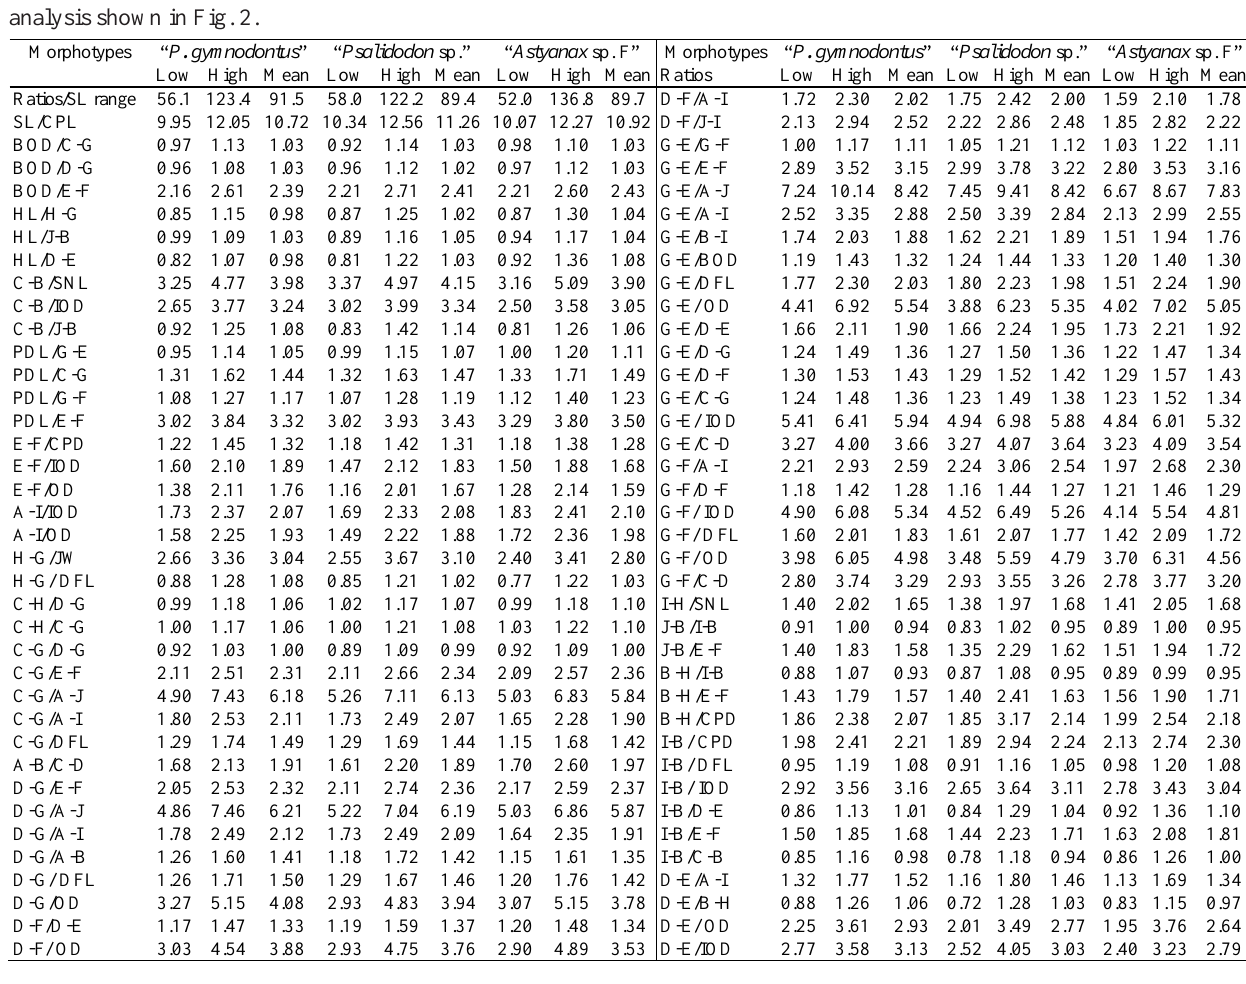
Table 2. The ranges of standard length (SL) and ratios suggested by canonical discriminant analysis are shown for the three morphotypes of Astyanax gymnodontus . Abbreviations of truss measurements are shown according to Table 1, and traditional measurements are: BOD, body depth; CPD, caudal-peduncle depth; CPL, caudal-peduncle length; DFL, dorsal-fin length; HL, head length; IOD, interorbital distance; JW, jaw width; OD, orbital diameter; PDL, predorsal length; and SNL, snout length. Bolded ratios correspond to those responsible for a faint separation between morphotypes in axis 2 of the principal components analysis shown in Fig. 2.